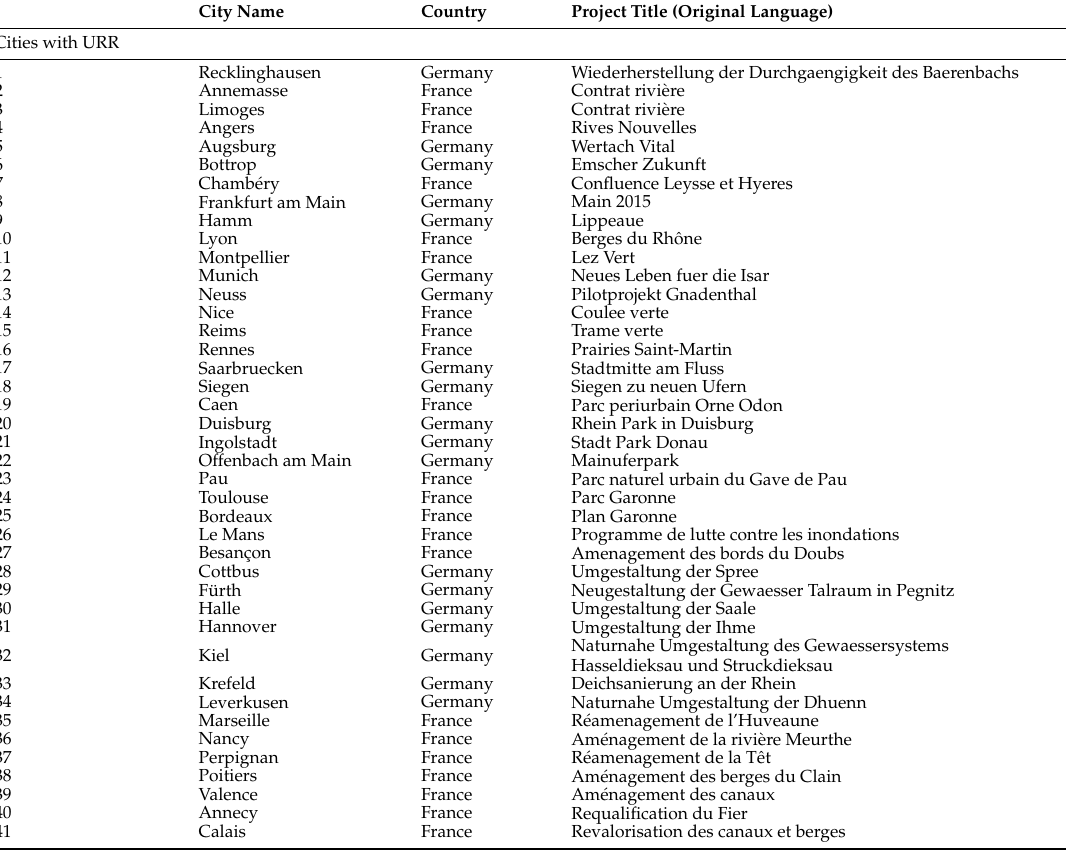
Table A1. List of the surveyed urban areas with, first, those with urban river restoration project(s); second, those without urban river restoration projects; and, third, those that did not answer the